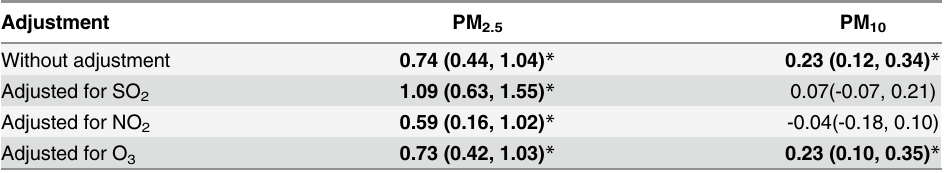
Table 3. Estimated percent difference in CHD outpatient and emergency department visits (95% CI) in association with a 10 μ g/m 3 increase in PM 2.5 and PM 10 with or without adjustment for gaseous